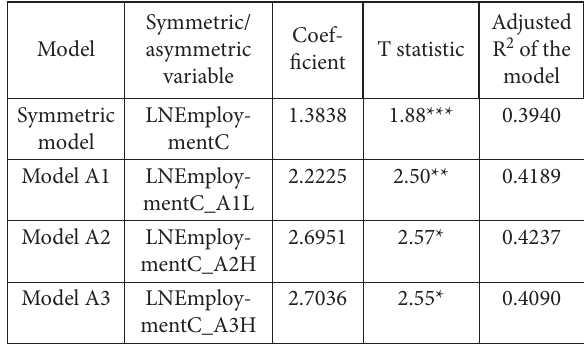
Table 7. Comparison of coefficients between the asymmetric variables and related symmetric variables (source: own study)